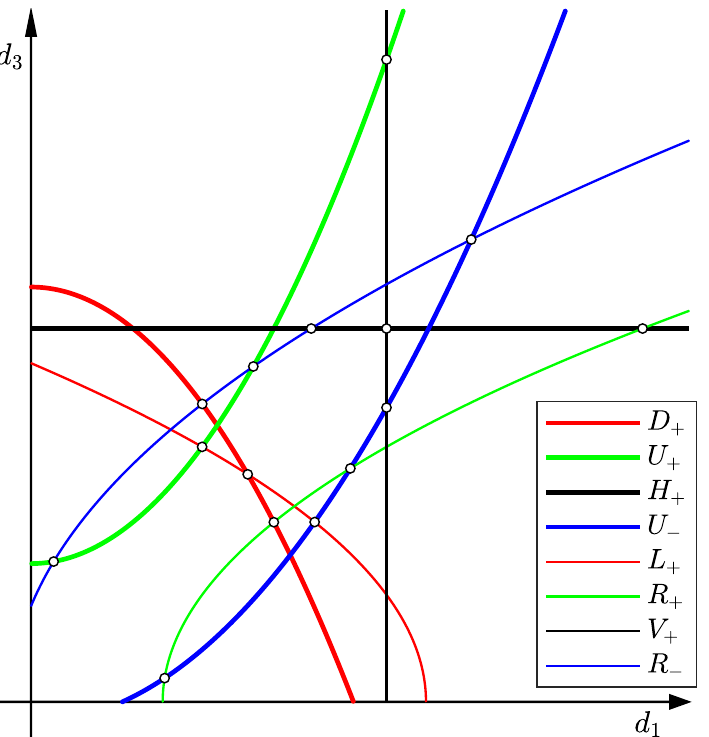
Figure 2. The solution of the system of two equations with two unknowns in Equation (8) can be represented by the intersection of two parabolas (9) parametrized by the boundary conditions. Thick lines illustrate possible parabola types for the first and thin lines for the second parabola in (9) while circles at intersection are possible solutions of